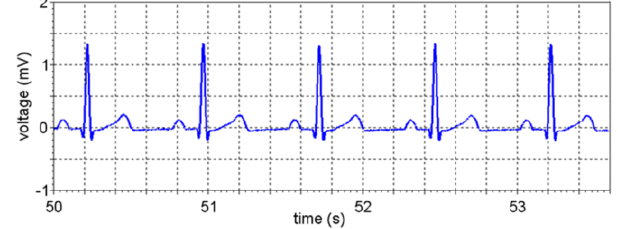
Figure 9. One-lead ECG signal measured with cooperative sensors on an ECG simulator